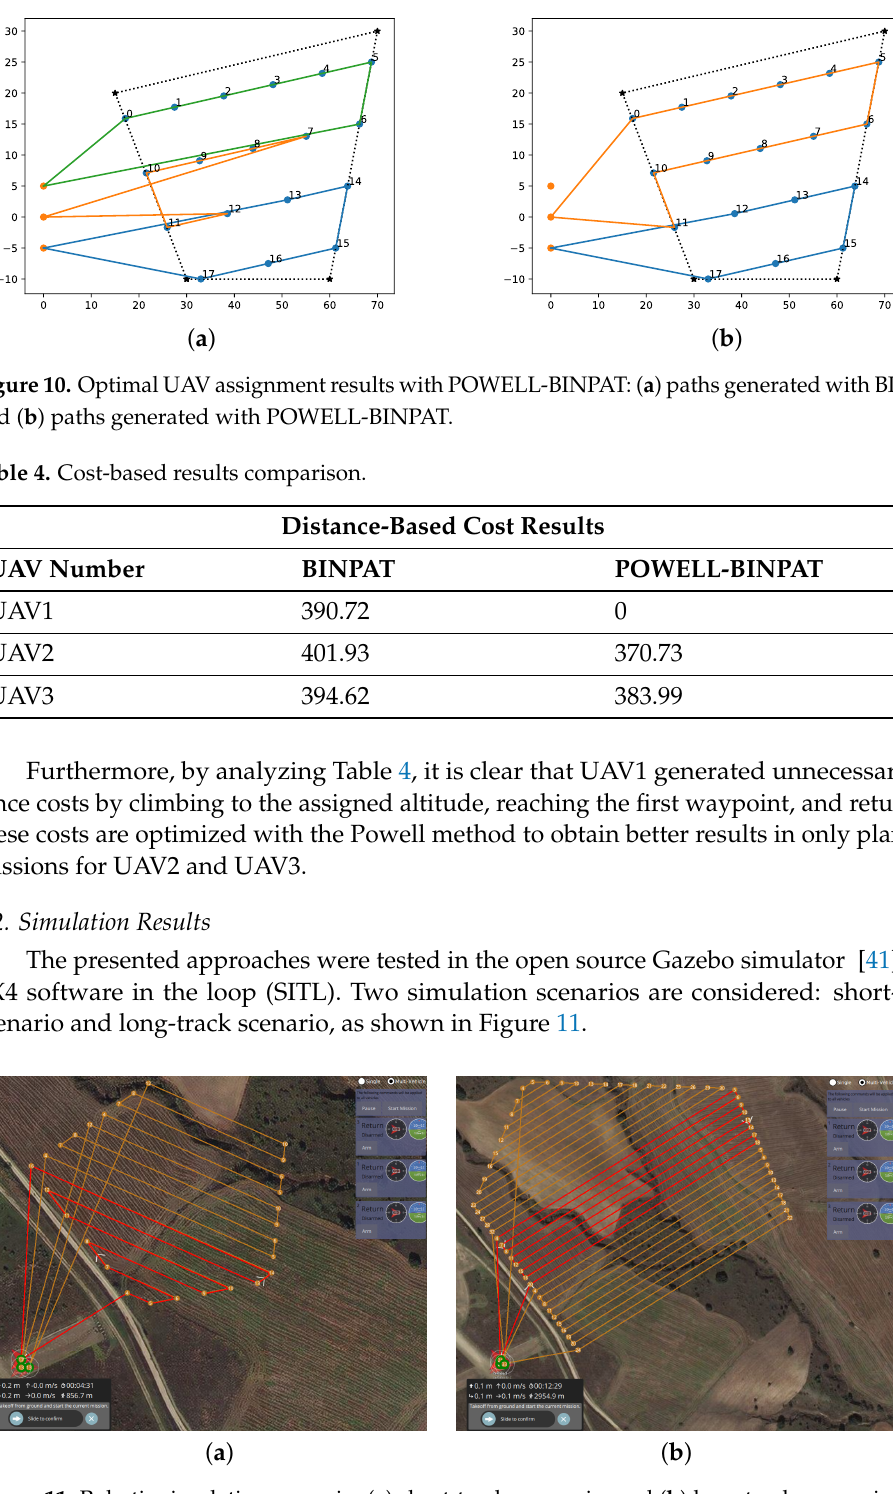
Figure 11. Robotic simulation scenario: ( a ) short-tracks scenario; and ( b ) long-tracks scenario.